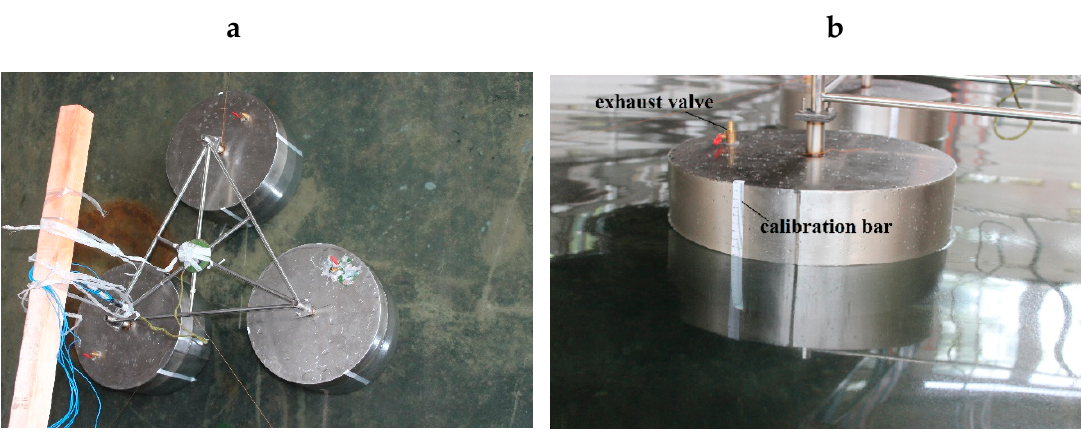
Figure 6. The prototype of the bucket foundation structure: ( a ) bucket foundation, ( b ) connecting frame.